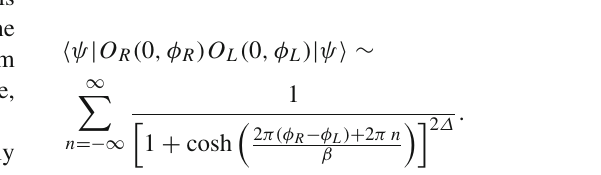
t = 0) respectively.